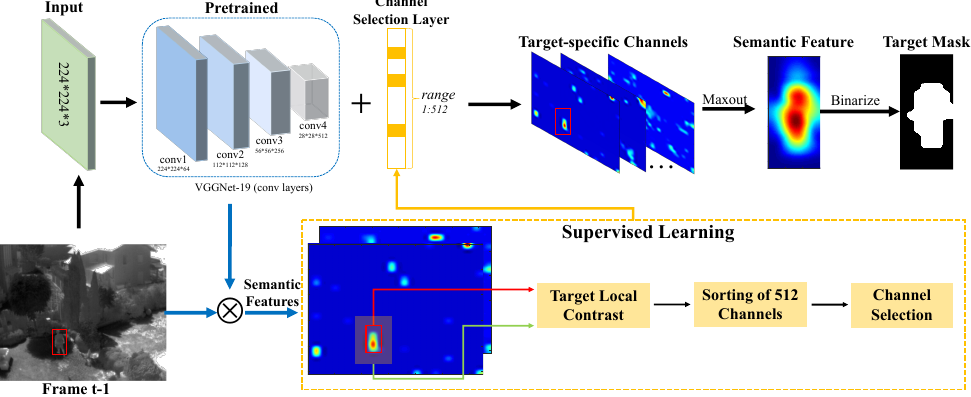
Figure 2. Illustration of generating binary mask template of the target based on CNN